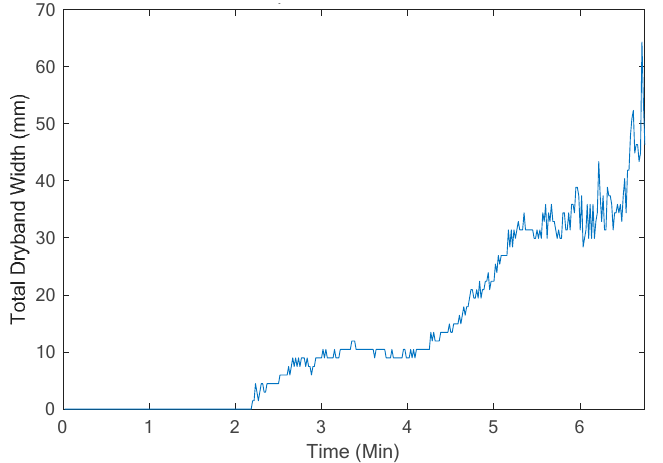
Figure 8. Cumulative dry-band extension on all the trunks. Ramp-test: Design CONV, ESDD = 0.64 mg/cm 2 , and a fog rate of 3 L/hr.